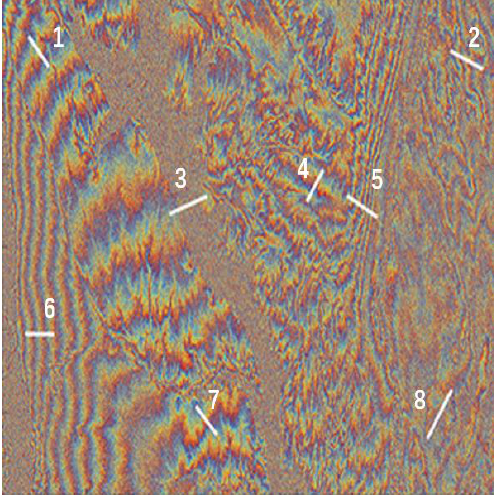
Figure 16. The real interferogram with the longest baseline(the order of white lines increases from left to right, from top to bottom).